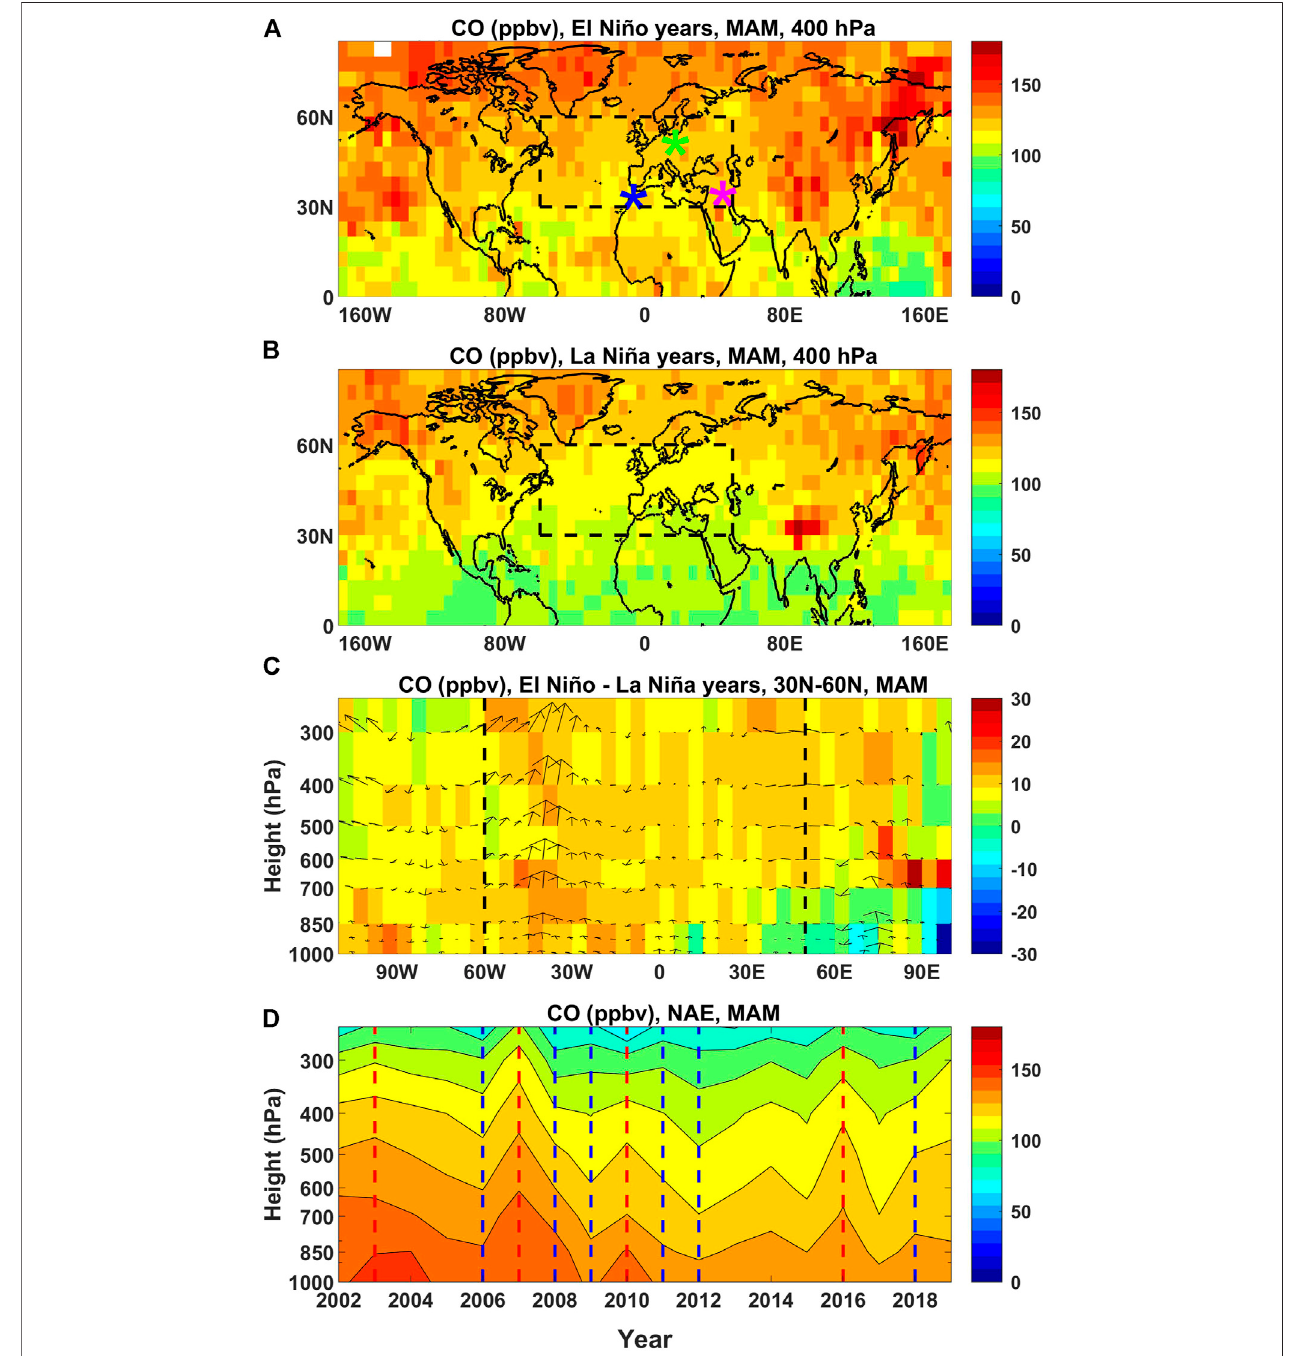
FIGURE 1 | (A) The seasonal mean CO distribution in March, April, and May (MAM, the same for the fi gures and tables below) at 400 hPa in El Niño years (2002, 2007, 2010, and 2016, the same for the fi gures and tables below). The dashed lines indicate the North Atlantic European region (NAE). The blue, magenta, and green stars indicate three ground-level sites: IZO (Izaña), WIS (Sede Boker) and JFJ (Jungfraujoch), respectively. (B) The same as (A) , but in La Niña years (2006, 2008, 2009, 2011,2012,and2018,thesameforthe fi gures andtablesbelow). (C) Thelongitude-altitudecrosssection oftheCOdifference betweenEl NiñoandLaNiñayears averaged over 30 ° N-60 ° N, MAM, overlaid with the corresponding wind difference between El Niño and La Niña years. The vertical wind velocity is enlarged by 1,000timesforillustration purposes.Thedashedverticallinesat60 ° Wand50 ° EindicatethelongitudinalbordersoftheNAE. (D) Interannualvariationduring2002 – 2019 inMAMCOconcentrationsaveragedovertheNAE(theboxedareain Figure1A ),varyingwithaltitude.RedandbluelinesdenoteElNiñoandLaNiñayears,respectively.